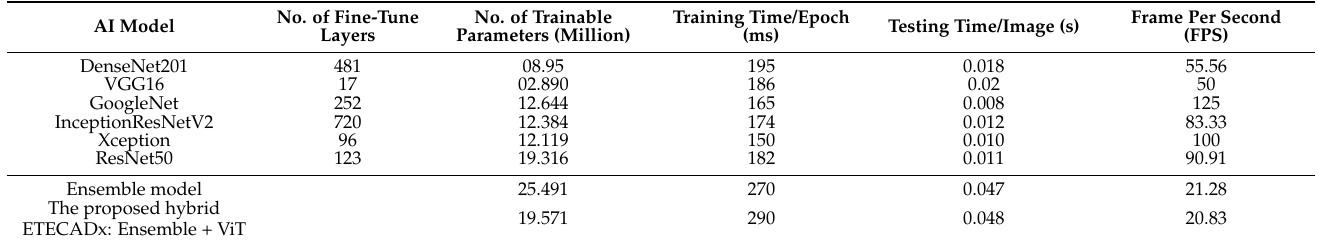
Table 9. Performance comparison of the proposed ensemble and ETECADx models against other individual AI models for the multi-classification approach.